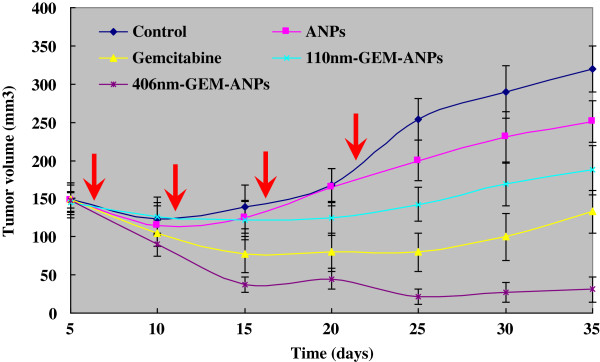
Tumor growth curves in a PANC-1-induced nude mice xenograft model after different treatments. Red arrows indicate the time point of administration.